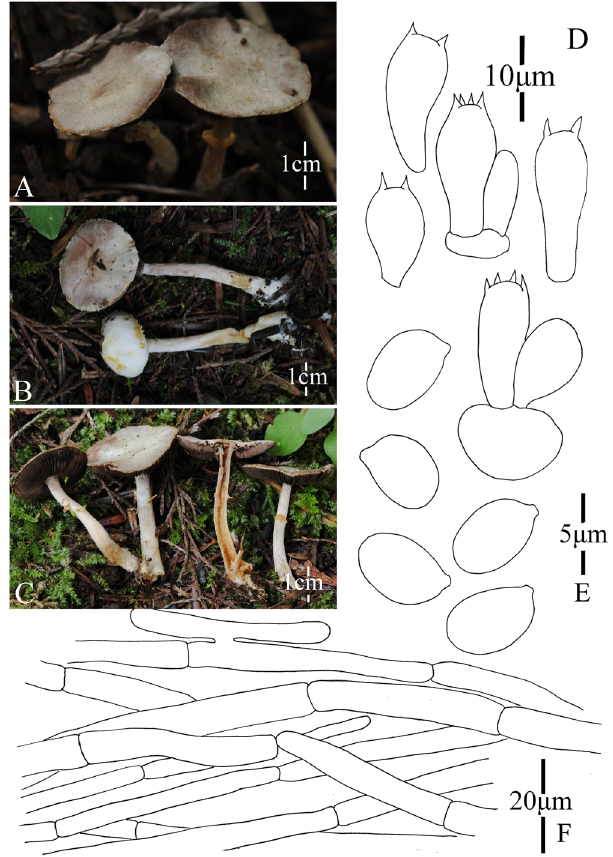
and phylogenetic features, we proposed A . pseudopallens as a new species, and this species is characterized by its nearly white and smooth pileus, elongate ellipsoid basidiospores and absence of cheilocystidia. 13. Agaricus elongatestipes M.Q. He & R.L. Zhao sp . nov .; Fig. 16 Fungal Names: FN570345 Faceoffungi Number: FoF 02933 Etymology : the epithet “ elongate ” refers to the slender basidiome of this species. Holotype : Laifengshan mountain, Tengchong County, Yunnan Prov., China, 8 July 2013, collected by Su Sheng-Yu, ZRL2013271 (HMAS275773, holotype). Original description: Pileus 55–58 mm in diam., convex; margin straight, slightly exceeding; surface covered by fibrils, ocherous-yellow, appressed, denser at disc, scattered towards margin, easily rubbed by raindrop; back- ground white, turn to red in wet. Context 1–2 mm thick, flesh, white. Lamellae 4–4.5 mm broad, free, crowded, pink, edge even, entire, intercalated with lamellulae. Annulus 12–22 mm in diam., single, fragile, membranous, white, pendant, smooth on both sides. Stipe 105–110 × 5–8 (14–15 at base) mm, cylindrical, bulbous at base, with rhizomorphs, hollow, surface above the annulus smooth, below fibrillose, white. Odour of almonds. Basidiome flavescent when touching, bruising and cutting. KOH reaction: positive yellow. Schäffer’s reaction: positive, reddish orange on dry specimen. Basidiospores 4.6–5.4 × 3.0–3.5 μ m, [x = 5.0 ± 0.2 × 3.3 ± 0.2, Q = 1.4–1.7, Q m = 1.5 ± 0.1, n = 20], ellip- soid, elongate, smooth, thick-walled, brown. Basidia 12.8–20.5 × 5.9–7 μ m, clavate, hyaline, 4-spored, smooth. Cheilocystidia 16–33 × 10– 18.5 μ m, smooth, clavate, pyriform or capitate with long narrow stipe, sometimes globose, containing yellow pigments. Pleurocystidia absent. Pileipellis a cutis composed of hyphae of 2.8–11.2 μ m in diam., smooth, cylindrical, hyaline or light brown, constricted at septa. Habitat : solitary on soil in forest. Other specimens examined : Laifengshan, Tengchong County, Yunnan Prov., China, 8 July 2013, 8 July 2013, collected by Yu Qing-Hua, ZRL2013265 (HMAS275772). Notes: In phylogeny analysis A . elongatestipes is represented by two specimens and clade together under the statistic support of 1.0/92 PP/BS in clade XI (Figs 1–2). This new species is characterized by its slender and related long stipe, weak fibrils on the cap and capitate cheilocystidia which contains yellow pigments. In the phylogeny, A . elongatestipes is sister to the unnamed specimen ZRLLD013 (Figs 1–2), but they are obviously different species because the cheilocystidia of ZRLLD013 are globose or broadly clavate.